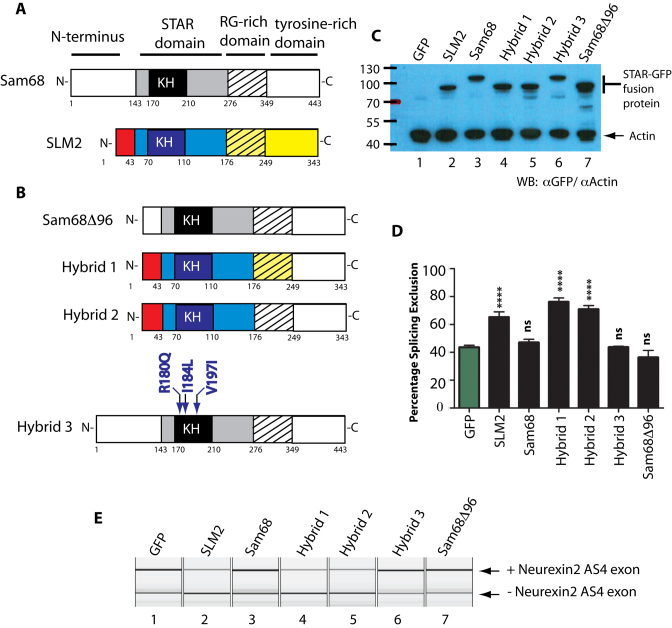
The STAR domain of SLM2 establishes substrate specificity for the Neurexin2 AS4 exon but not through amino acids involved in RNA–protein contacts. (A) Modular structures of SAM68 and SLM2 protein, showing the important domains above, and amino acid residue positions below each protein (1–343 for SLM2, and 1–443 for SAM68). (B) Variant SAM68 and SLM2 proteins used in splicing analyses, with SLM2-derived domains coloured as in part (A) to distinguish them from their corresponding SAM68-derived domains (in black and white). (C) Western blot showing relative expression of the different SLM2 and SAM68-GFP fusion proteins relative to actin. (D) Bar chart and (E) example capillary gel electrophoretogram showing levels of splicing of a Neurexin2 AS4 exon from a co-transfected minigene (6) measured after expression of either a GFP fusion protein (black bars) or GFP only (green bar). Statistical significances were analysed using Graphpad and are indicated as **** (P < 0.0001), or ns (not significant).